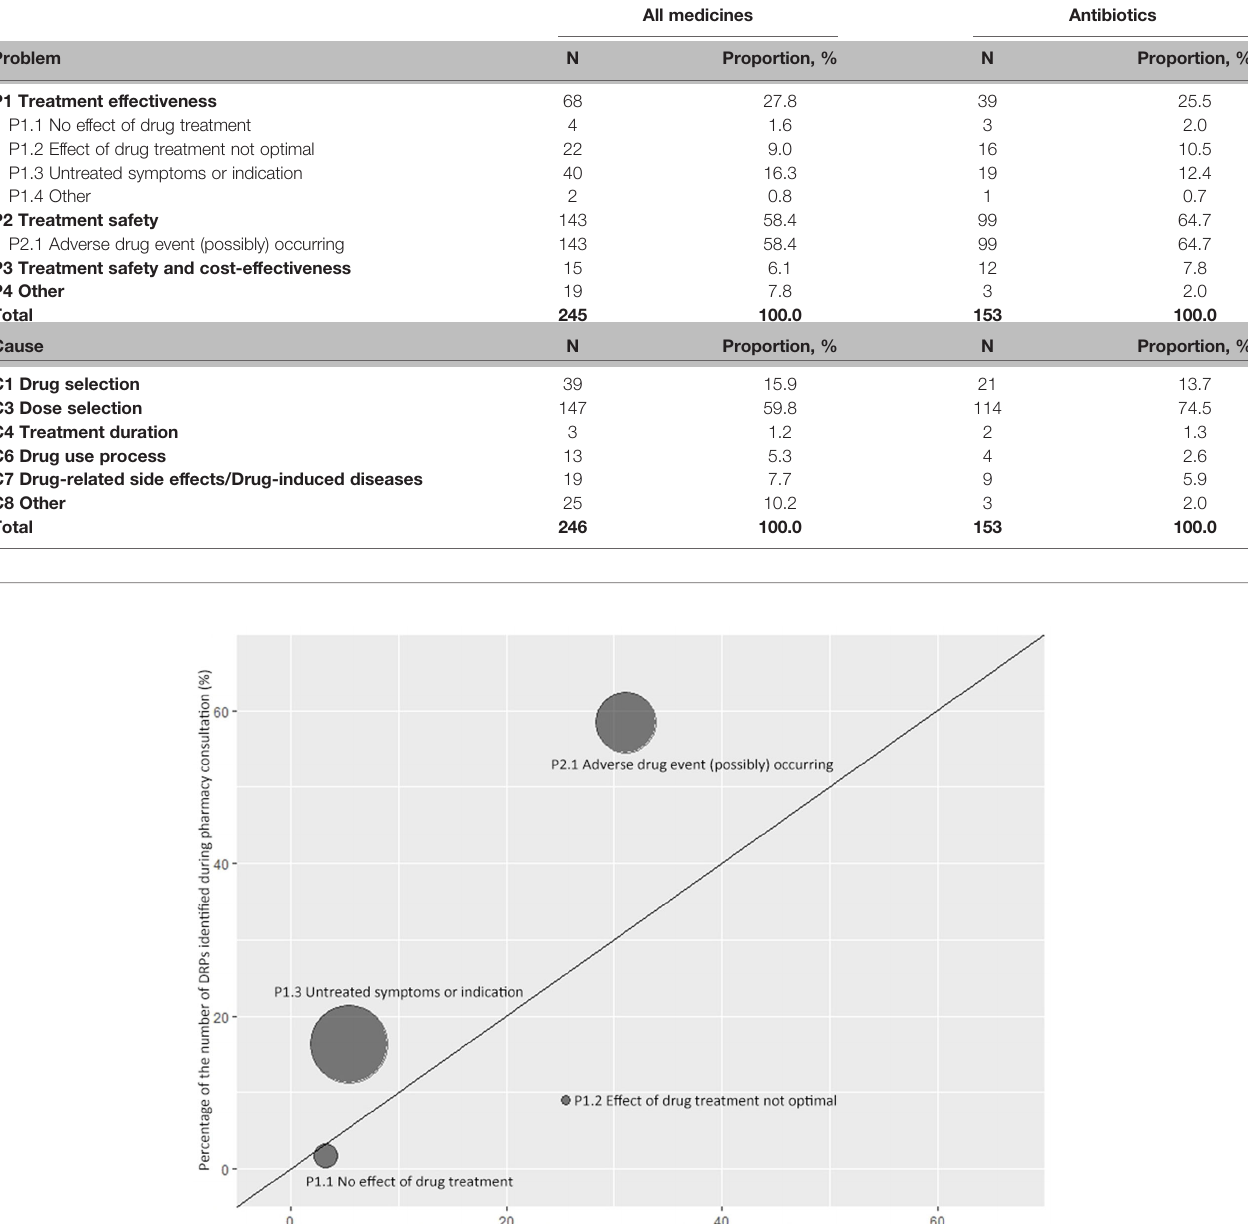
TABLE 3 | Number of drug-related problems and causes of all medicines and antibiotic medicines of pharmacy consultation. All medicines Antibiotics